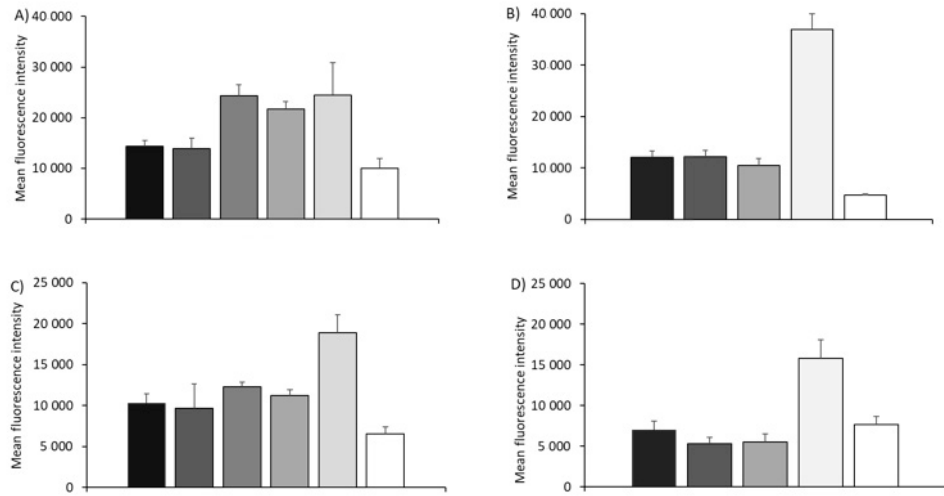
Figure 2. Cell association of formulations in BHK cell line expressed as mean fluorescence intensity (MFI). Mean fluorescence intensity of BHK cells after 16 h incubation with DOTAP-based ( A , C ) and DDA-based ( B , D ) liposomes, SLNs, NPs and emulsions in either 5% FCS ( A , B ) or FCS-free media ( C , D ). Results are represented as mean ± SD of 3 independent experiments.